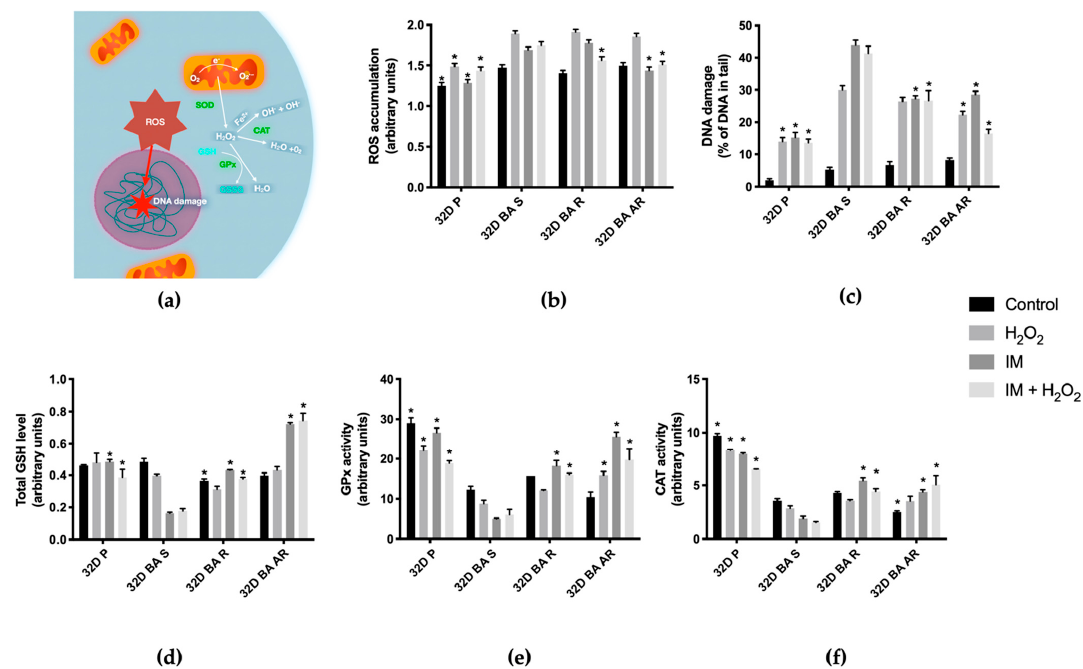
Figure 2. ( a ) Schematic overview of potential oxidative stress responses that may be induced in leukemia cells. The production of ROS is triggered by the disturbances of mitochondria function and causes the activation of antioxidant enzymes or cellular damage, e.g., DNA lesions; ( b ) Comparison of the level of reactive oxygen species in BCR-ABL1—positive and parental 32D P cells under control conditions and after treatment with IM, H 2 O 2 or IM + H 2 O 2 ; ( c ) Comparison of DNA damage in BCR-ABL1—positive and parental 32D P cells under conditions as described above; ( d ) Comparison of total GSH level in BCR-ABL1—positive and parental 32D cells under conditions as described above ( e ) Comparison of glutathione peroxidase activity in BCR-ABL1—positive and parental 32D cells under conditions as described above; ( f ) Comparison of catalase activity in BCR-ABL1—positive and parental 32D cells under conditions as described above. We cultured cells with IM for 24 h and with H 2 O 2 for 30 min; in case of co-incubation, we added H 2 O 2 at the end of IM incubation. IM was used in 1 µM concentration for 24 h and H 2 O 2 in 100 µM for 30 min. * p < 0.05, the asterisk indicates a significant difference after treatment between a given cell line and the 32D BA S cells, n ≥ 3, we presented results as mean ± SEM.